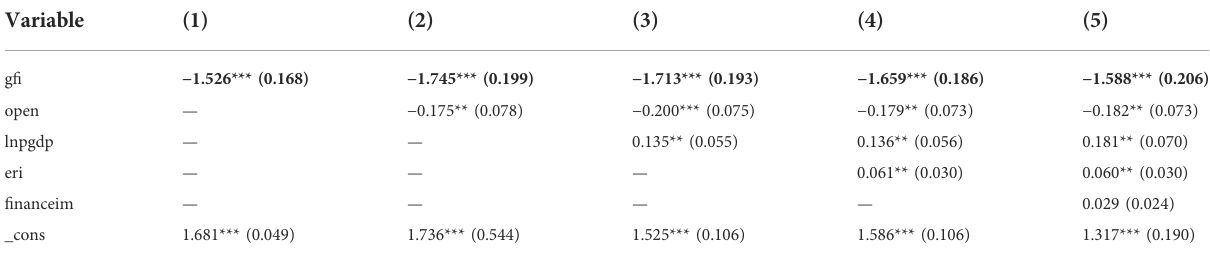
TABLE 9 Results of robustness test.